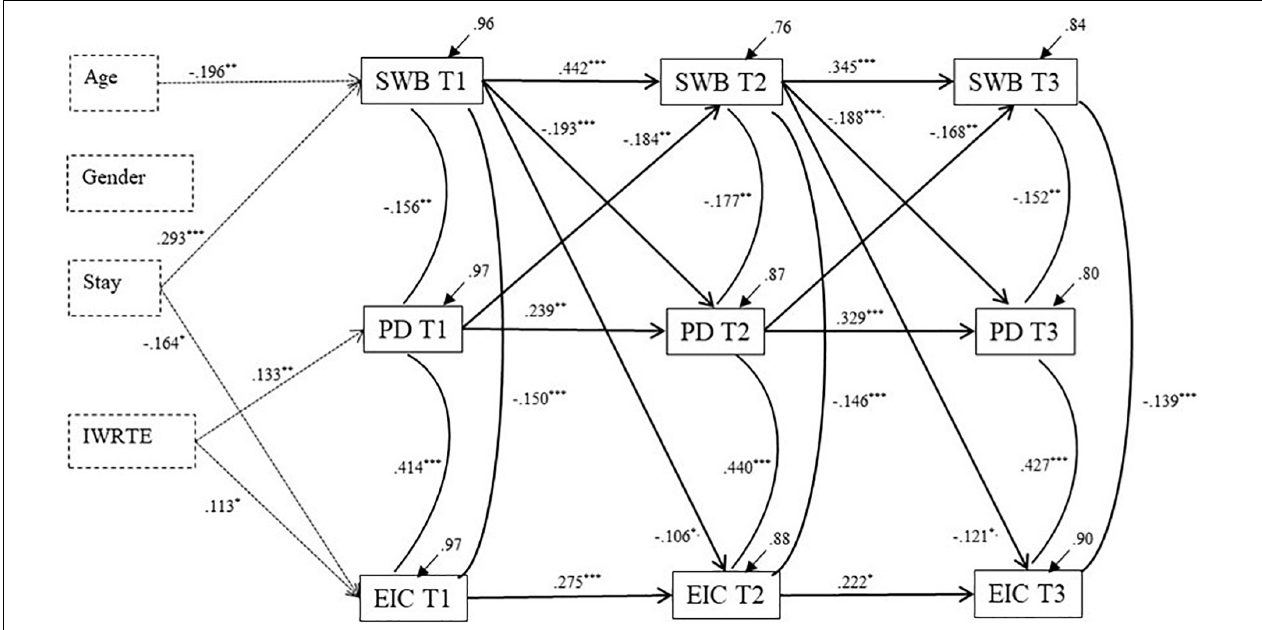
FIGURE 2 | Final model (Model 4). IWRTE, Impact of war-related trauma; Stay, Length of stay. SWB T l-SWB T3, PD T l -PD T3, and E CT l-EICT3 represent data over 3 observations for subjective well-being, perceived ethnic-based discrimination and ethnic identity crisis, respectively. The residual variance components (error variances) indicate the amount of unexplained variance. Standardized parameter estimates were reported only for the significant paths. ∗ p < 0.05, ∗∗ p < 0.01, ∗∗∗ p < 0.001.